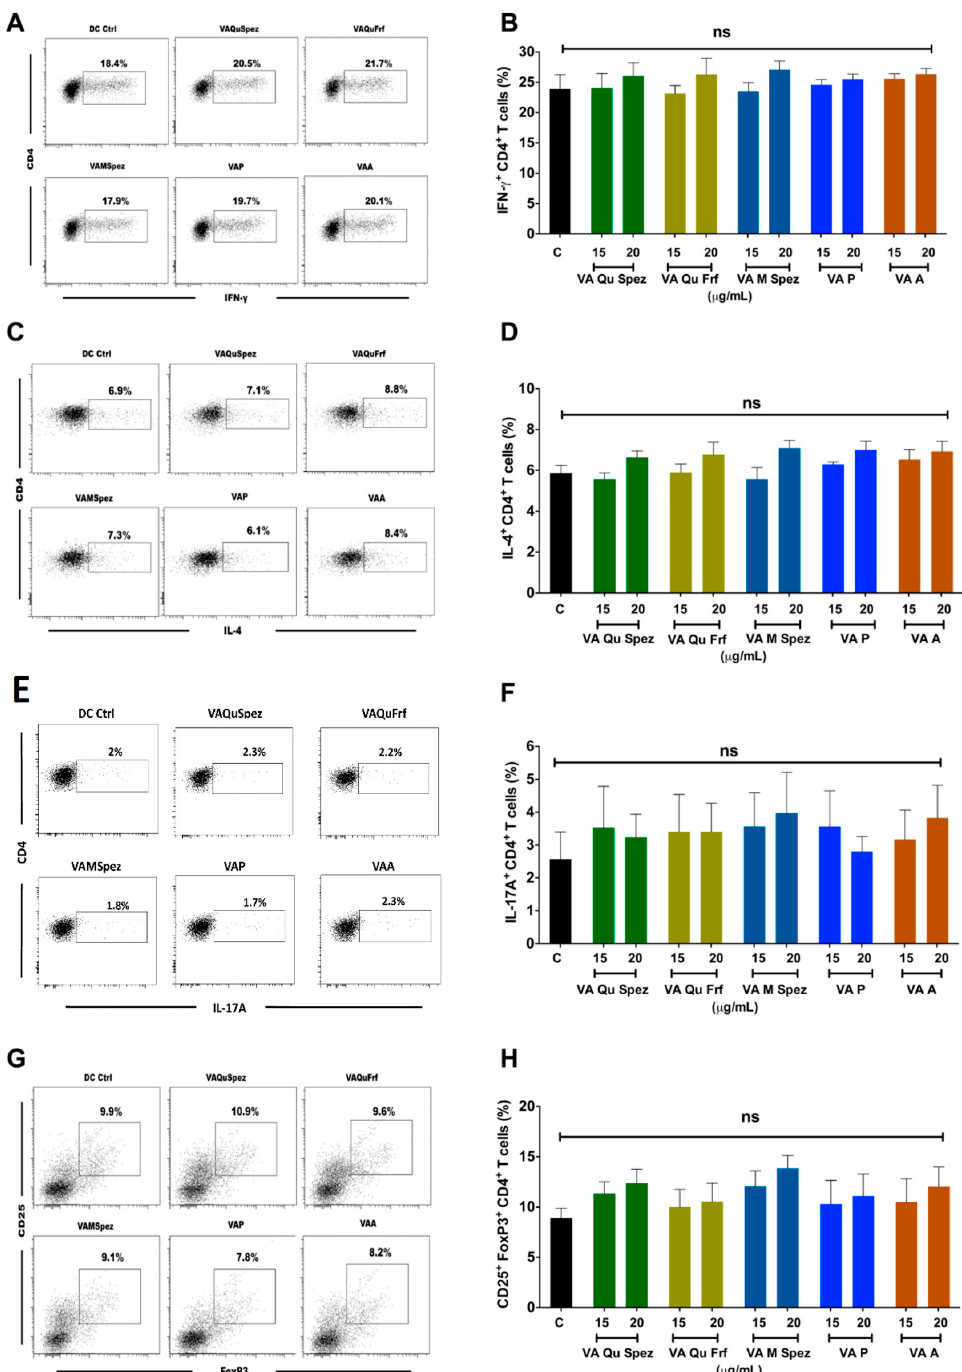
Figure 1. E ff ect of various VA preparations on the CD4 + T cell responses. DCs were treated with medium alone (DC Ctrl, labelled as ‘C’) or with five preparations of VA for 48 h. These DCs were co-cultured with CD4 + T cells at 1:10 ratio. After five days of co-culture, the cells were analysed for the various CD4 + T cell subsets by intra-cellular cytokines (IFN- γ , IL-4, IL-17A) or transcription factor (FoxP3) for Th1, Th2, Th17 and Tregs respectively. ( A , C , E , G ) representative dot plots showing the proportion of IFN- γ + , IL-4 + , IL-17A + CD4 + T cell and CD4 + CD25 + Foxp3 + T cells respectively; ( B , D , F , H ) Percentage (mean ± SEM, six independent donors) of IFN- γ + Th1, IL-4 + Th2, IL-17A + Th17 and CD4 + CD25 + Foxp3 + Treg cells respectively. ns, non-significant.